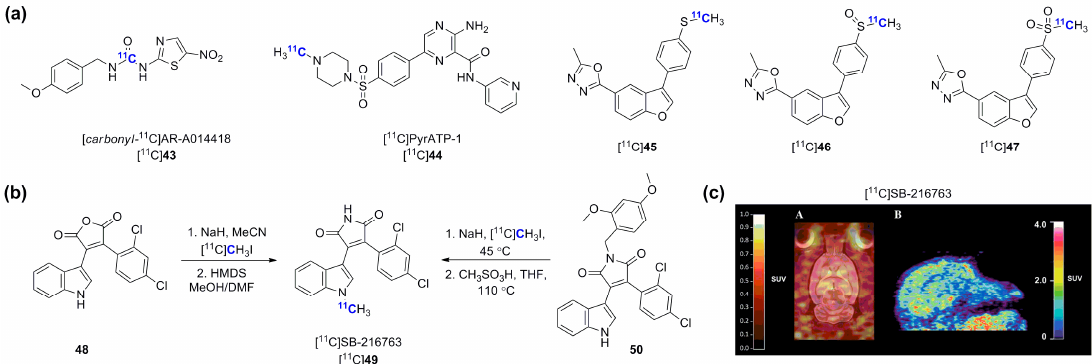
Figure 14. ( a ) Chemical structures of representative novel GSK-3 radiolabeled inhibitors; ( b )